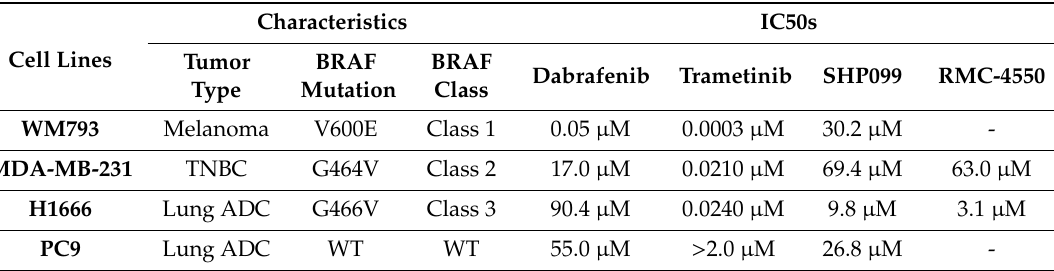
Table 2. Cell line characteristics.